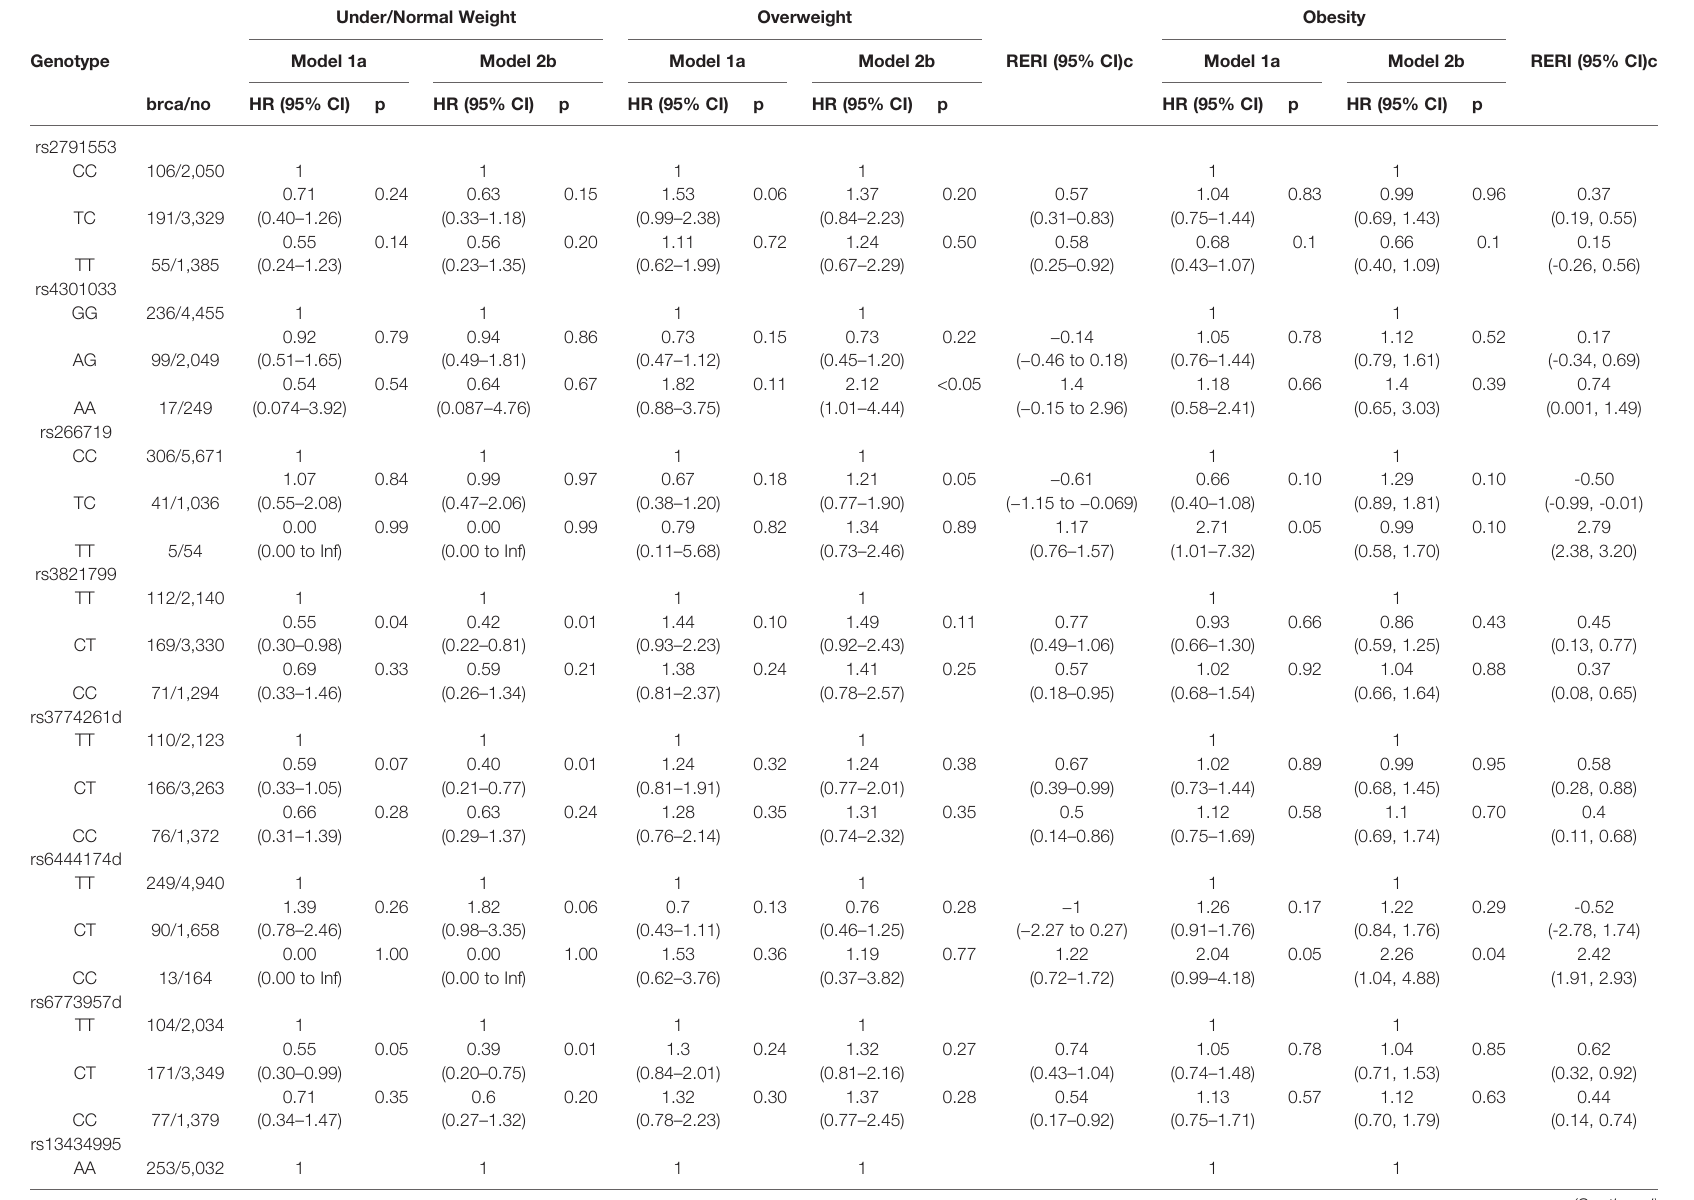
TABLE 3 | Association between adiponectin-related SNPs and postmenopausal invasive breast cancer risk, by BMI